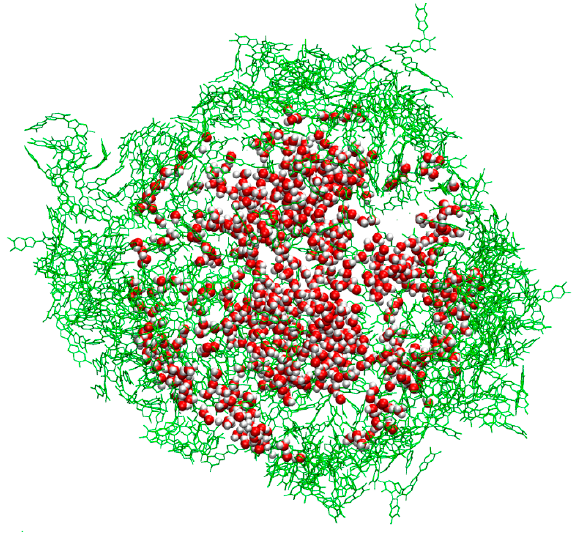
Figure 7. Distribution of water molecules within a PDA nanosphere in the TET-2 model. In green are displayed the outer TET-2 oligomers to indicate the dimensions of the nanosphere.